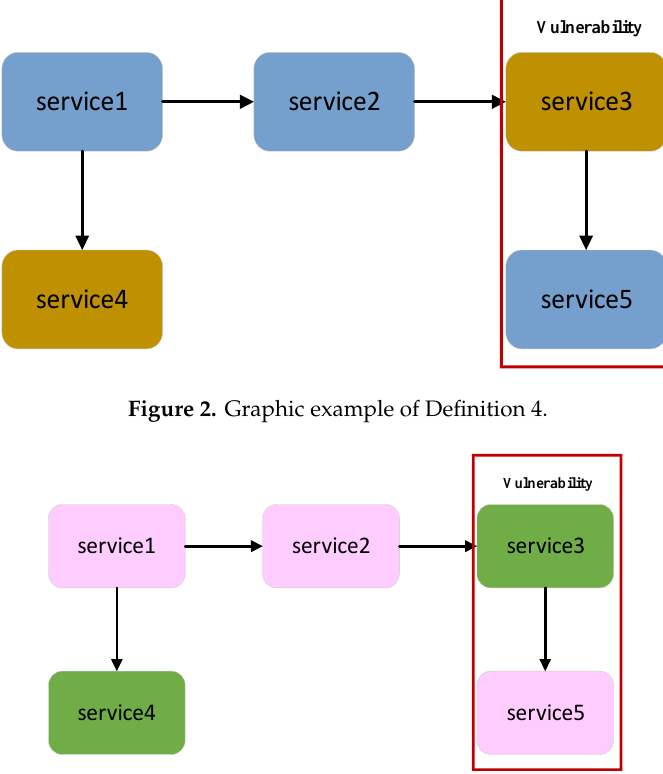
Figure 3. Graphic example of Definition 5.